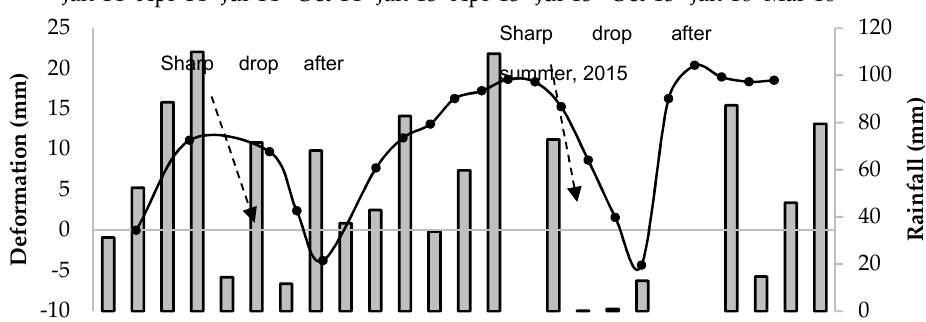
Figure 11. Edge drop at consecutive summer seasons at SH 342 site.